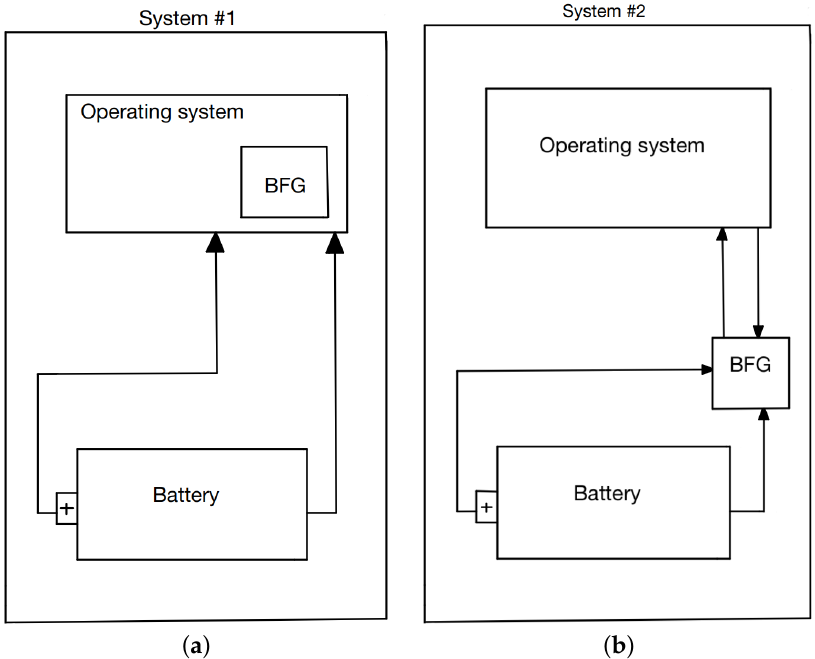
Figure 3. Types of BFG installation in a system. ( a ) BFG within OS. ( b ) BFG outside